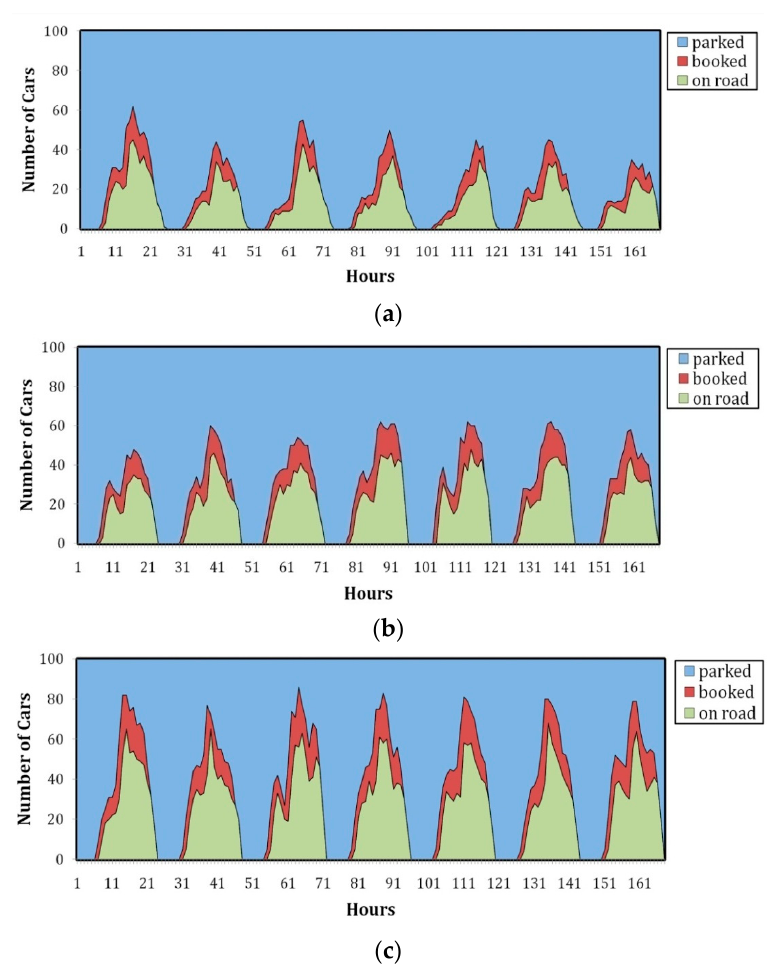
Figure 7. Car status over time ( a ) without relocation; ( b ) rebalancing relocation; and ( c ) proposed forecasting relocation.